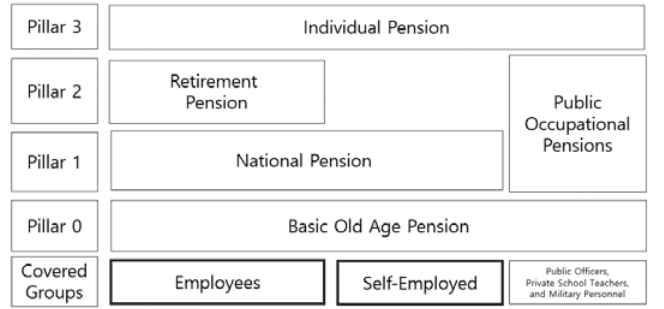
Figure 13. Multipillar old age income security system. Source: Ministry of Health and Welfare [47].